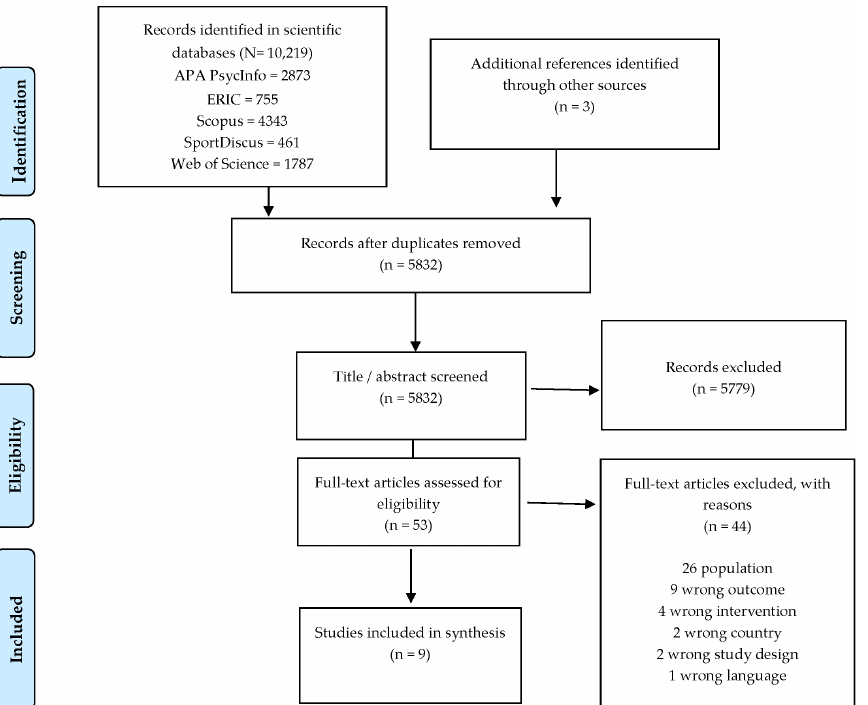
Figure 1. Flow chart of the screening process.